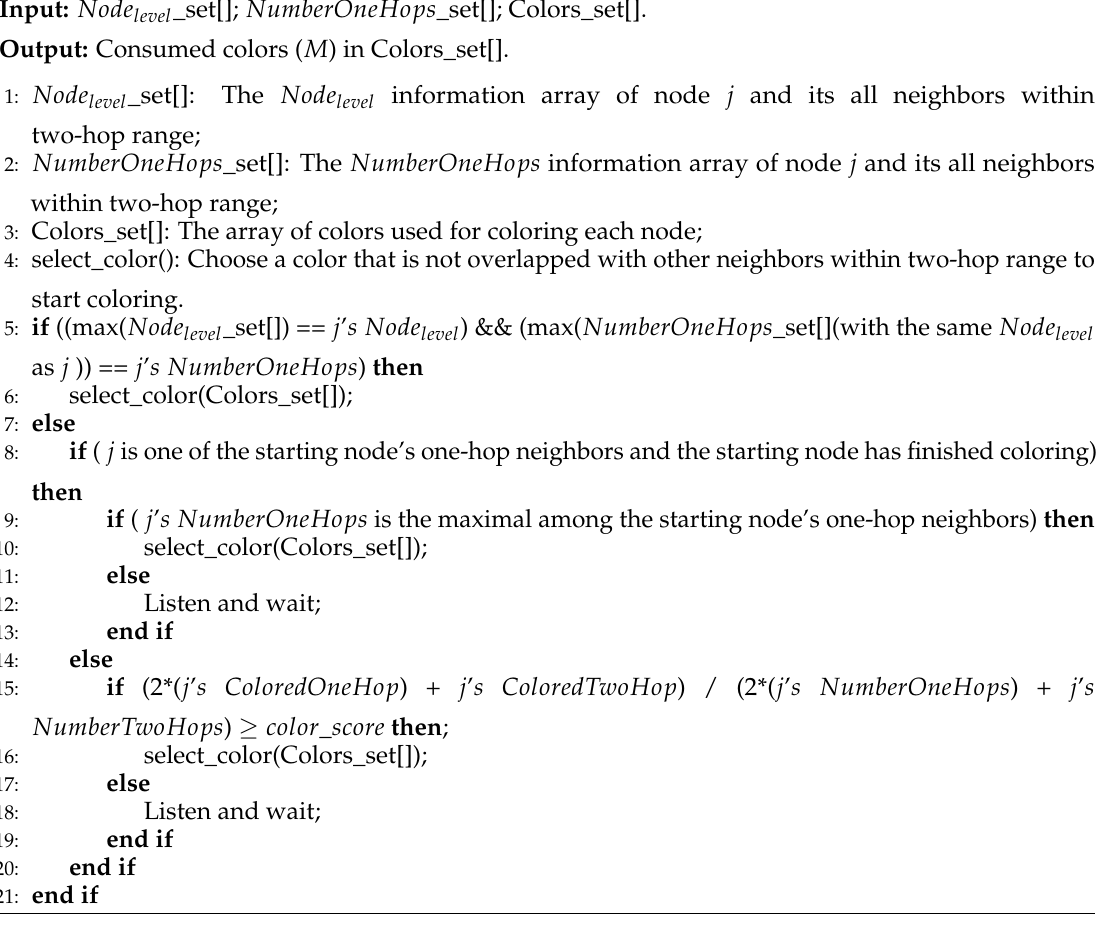
Algorithm 3 The MD-CCH Distributed Vertex Coloring Algorithm of Node